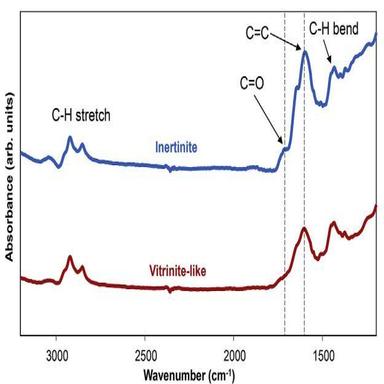
Micro-FTIR spectra obtained in ATR mode of different organic macerals in a Carynginia Shale sample (Ro = 1.1%) obtained from the Perth Basin.